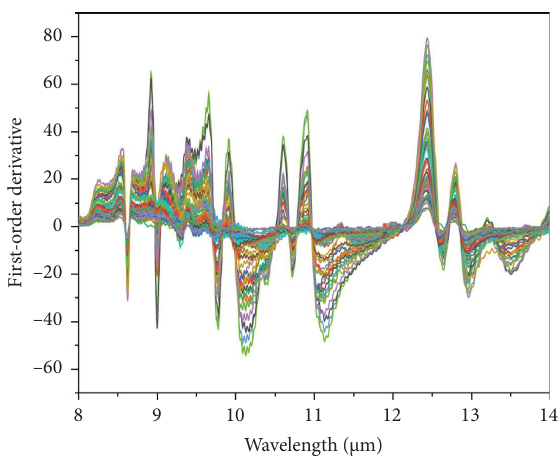
Figure 4: Absorption spectra by frst-order derivative.